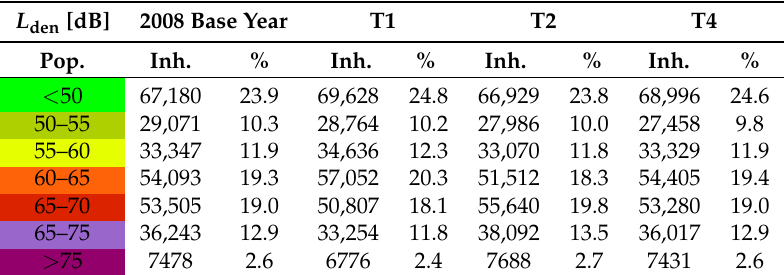
Table 6. Distribution of the inhabitants (Inh.) according to its noise exposure. Table 9. Distribution of the inhabitants (Inh.) according to its noise